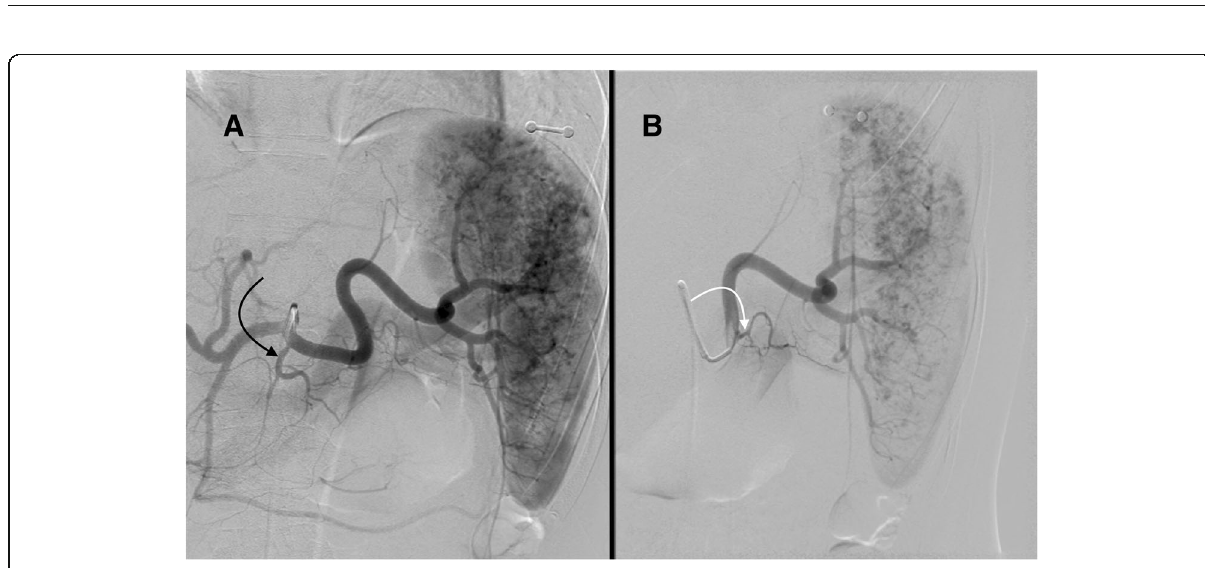
Fig. 1 Celiac angiogram ( a ) in a 22 yo female status post rollover motor vehicle accident with grade III splenic laceration shows the dorsal pancreatic artery (curved black arrow) arising from the proximal splenic artery. The dorsal pancreatic artery arises from the proximal splenic artery in approximately 50% of cases. Selective splenic angiogram ( b ) shows the great pancreatic artery (curved white arrow) arising from the mid splenic artery. Note the multifocal areas of contrast pooling within the splenic parenchyma consistent with multifocal traumatic